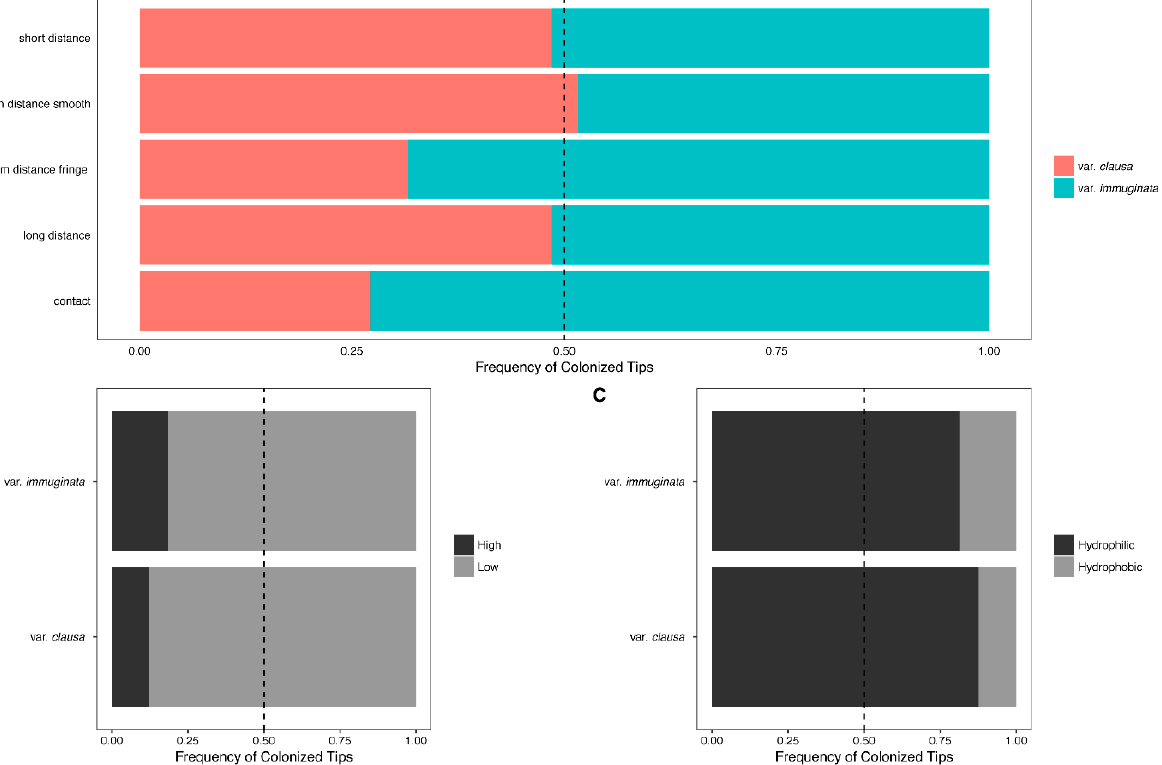
Figure 4. Fungal trait distribution for Pinus clausa variety across sites for exploration type ( A ), rhizomorph biomass ( B ), and hydrophobicity ( C ). The frequency of colonized tips was calculated as the proportion of total identified tips for a particular fungal trait belonging to each variety ( Pinus clausa var. clausa (salmon) and Pinus clausa var. immuginata (blue)). The dotted line represents a frequency of 50% (equal likelihood the trait occurred in either variety).